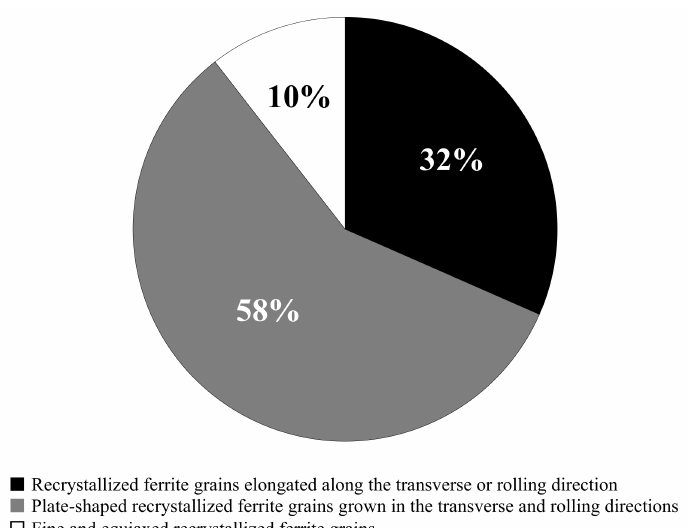
Figure 7. Fraction of 3D recrystallized ferrite grain morphology.